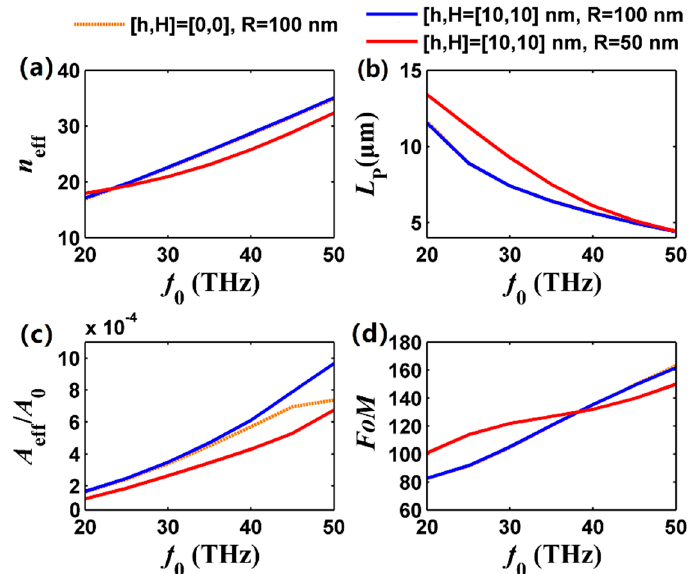
Figure 5. Dependence of the FGPM properties on frequency. ( a ) Effective mode index; ( b ) propagation length; ( c ) normalized mode size; and ( d ) FoM. The dotted brown curve for [ h , H , R ] = [0,0,100] nm, solid blue curve for [ h , H , R ] = [10,10,100] nm, and solid red curve for [ h , H , R ] = [10,10,50] nm. The frequency ranges from 20 THz to 50 THz. Other parameters are the same as Figure 2.